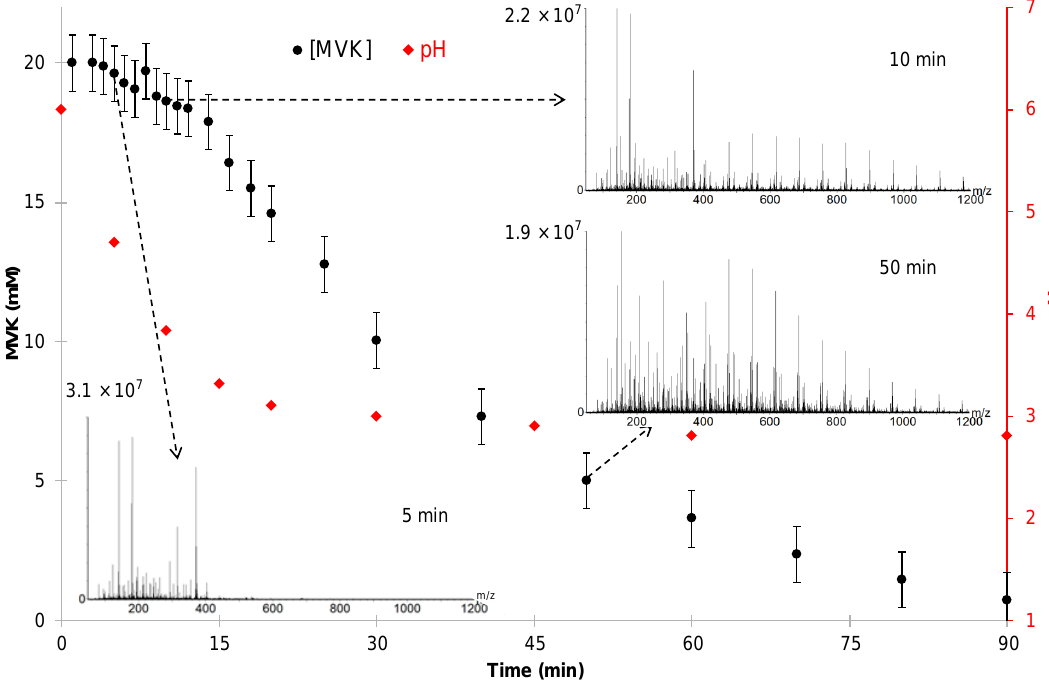
Fig. 5. MVK time profile (as measured by UV Spectroscopy) and mass spectra (obtained using UPLC-ESI-MS for the retention time range 0–5min in the positive mode) at 5, 10 and 50min of reaction, during experiment A (MVK 20mM, 25 ◦ C, under supersaturated O 2 initial